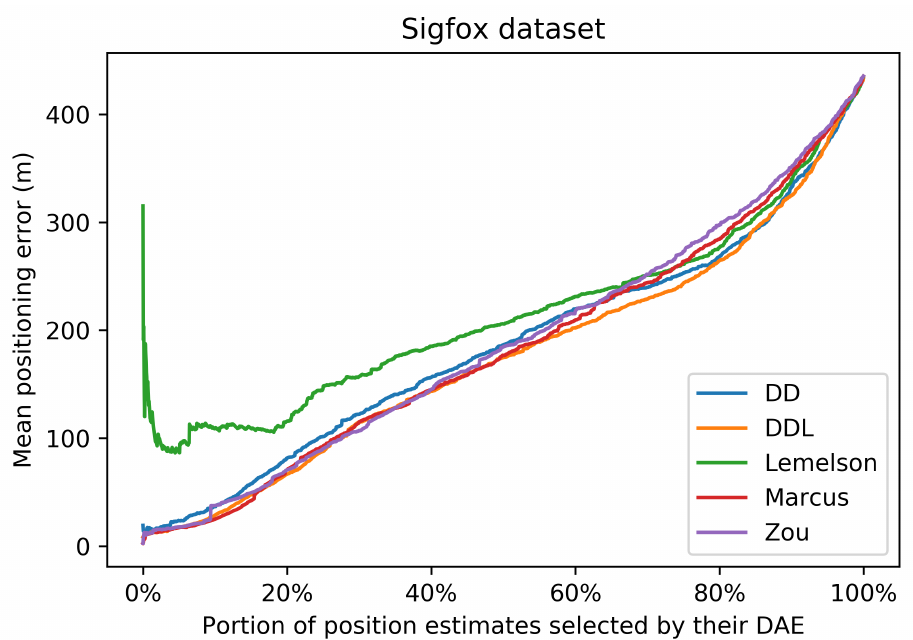
Figure 7. In this plot, the horizontal axis represents the percentage of location estimates selected based on their ranking according to the DAE values. The ranking of each DAE method is depicted with a different color. The vertical axis reports the respective mean positioning error for each selected portion of the original dataset. The values correspond to the validation set of the Sigfox